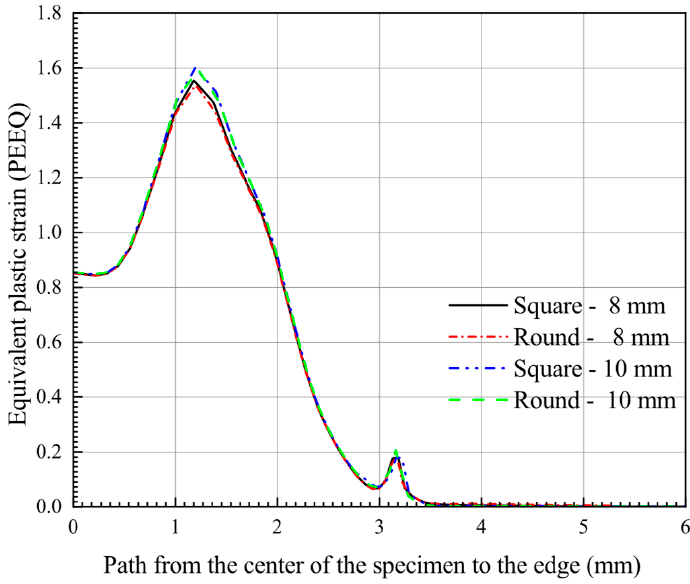
Figure 16. PEEQ distribution on the bottom surface of the specimen at the maximum force in the path from the center of the specimen to the edge.